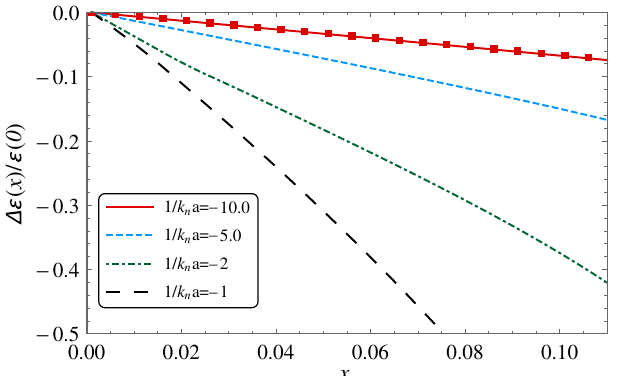
FIG. 9. The concentration dependence of the zero-momentum polaron energy Eq. (13) for m=m and various impurity-boson scattering lengths. We also show the perturbative result Δ ε ð x Þ ¼ − n T 2 1 =k a ¼ − 10 . n